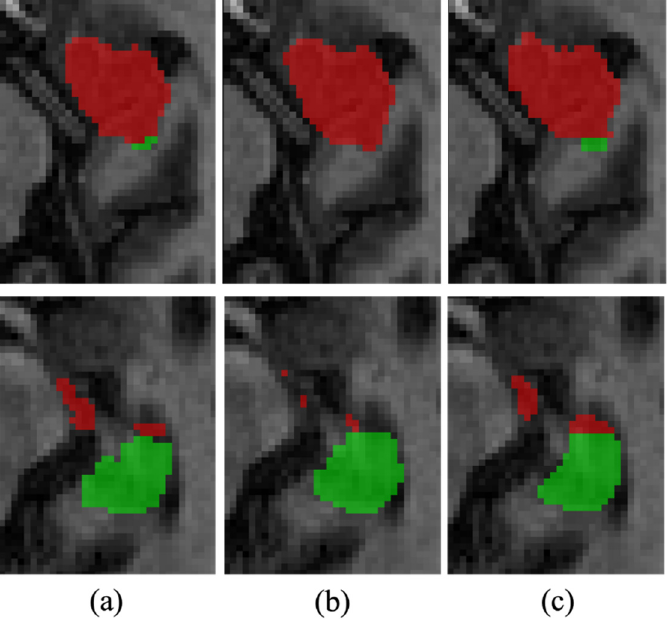
Data are presented as mean ± standard deviation.